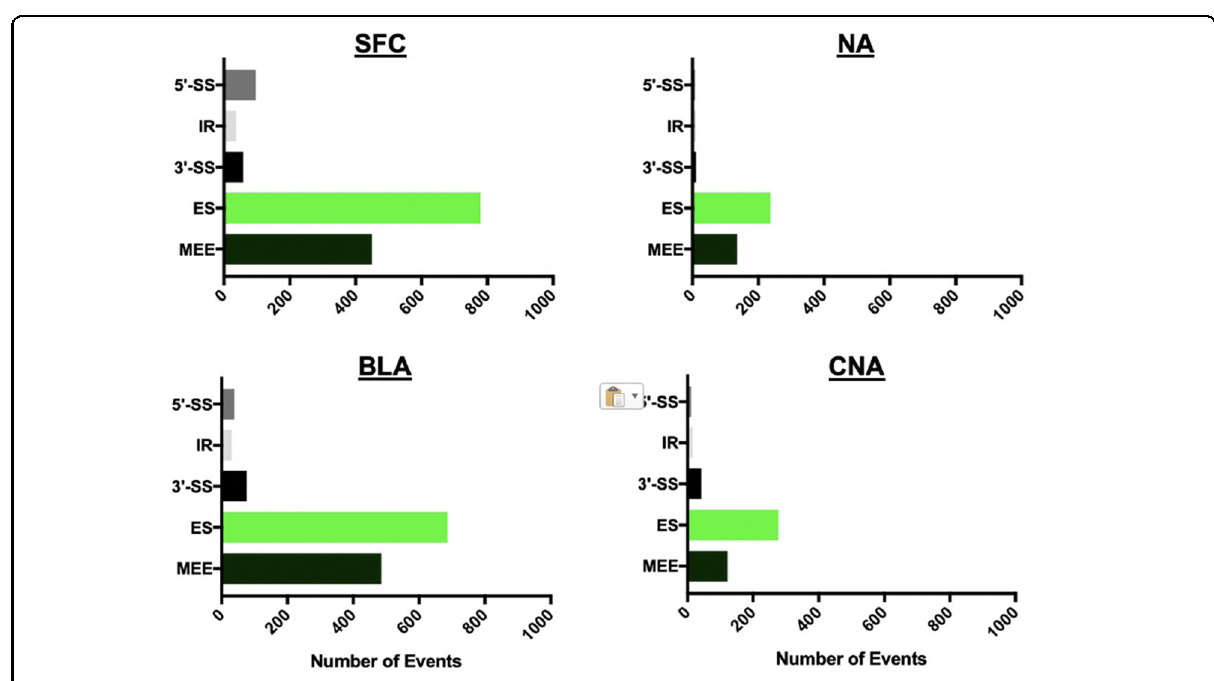
Fig. 2 Mis-splicing patterns in brain regions of patients with alcohol use disorder. SFC superior frontal cortex, NA nucleus accumbens, BLA basolateral amygdala, CNA central nucleus of the amygdala; 5 ′ -SS alternative 5 ′ splice site, IR intron retention, 3 ′ -SS alternative 3 ′ splice site, ES exon skipping, MEE mutually exclusive exons.